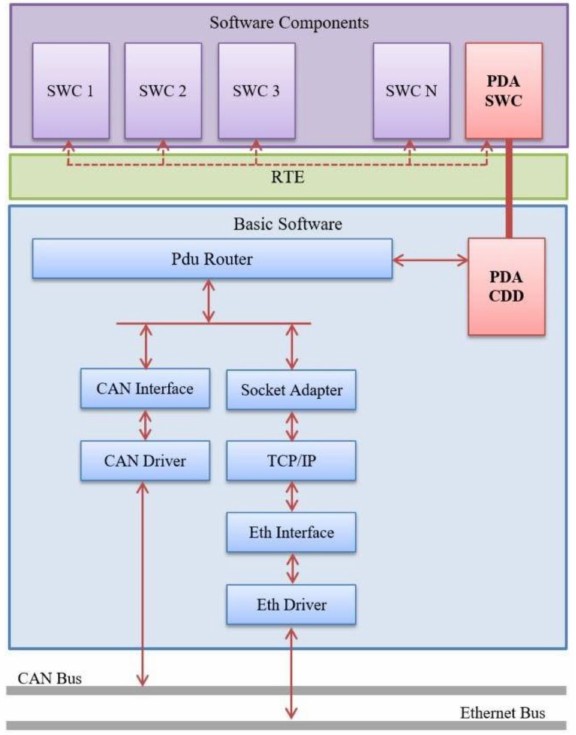
Figure 6. PDA module in AUTOSAR development